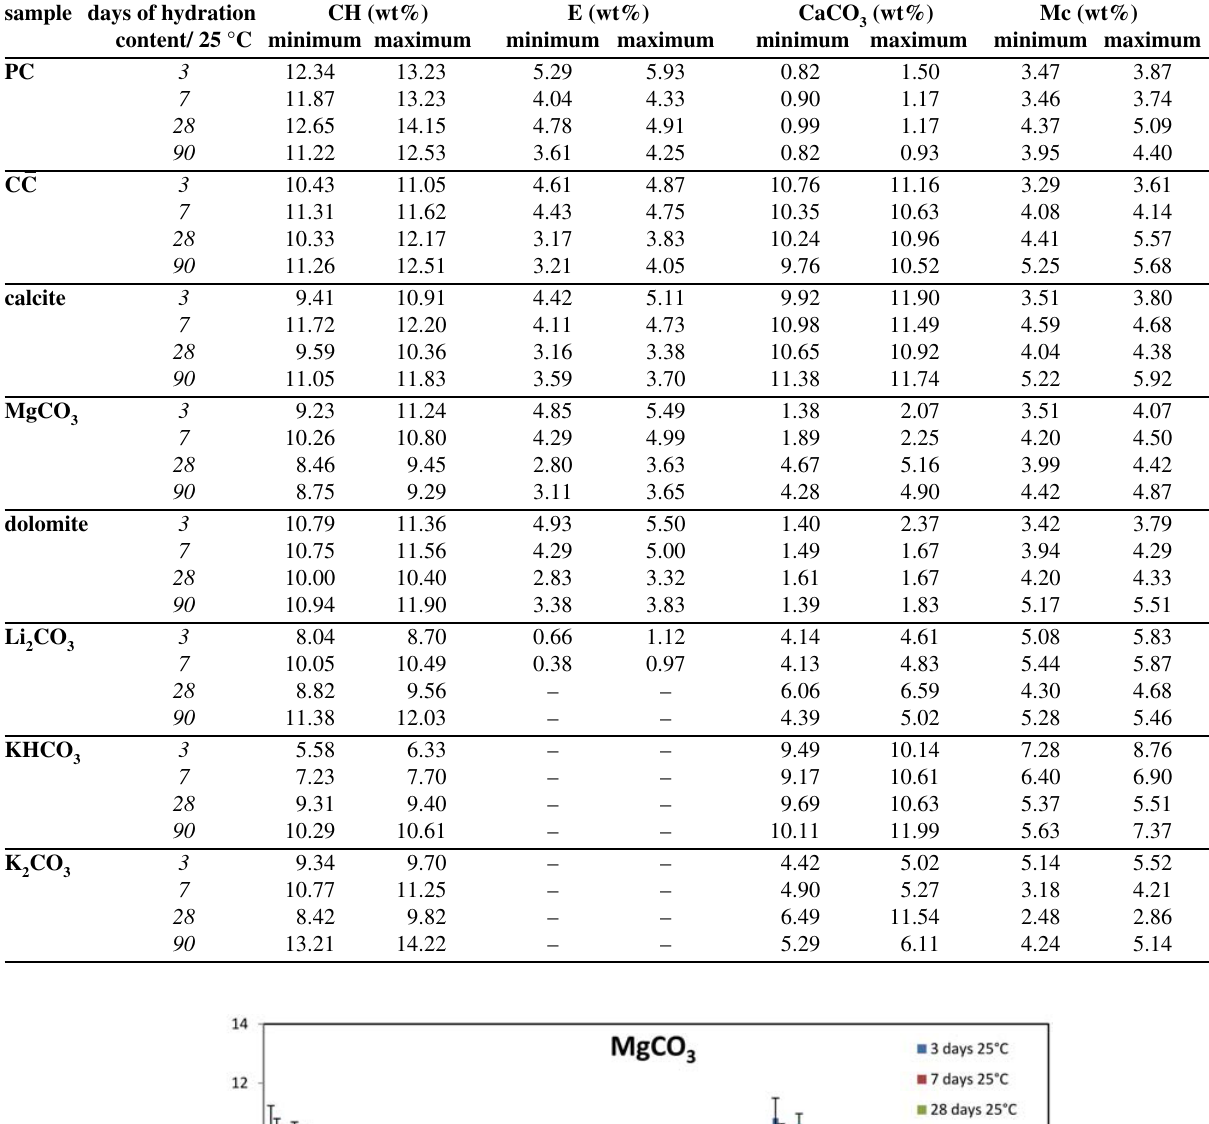
Table 4. The minimum and maximum contents of hydration products in relation to hydration time and 25 °C. sample days of hydration